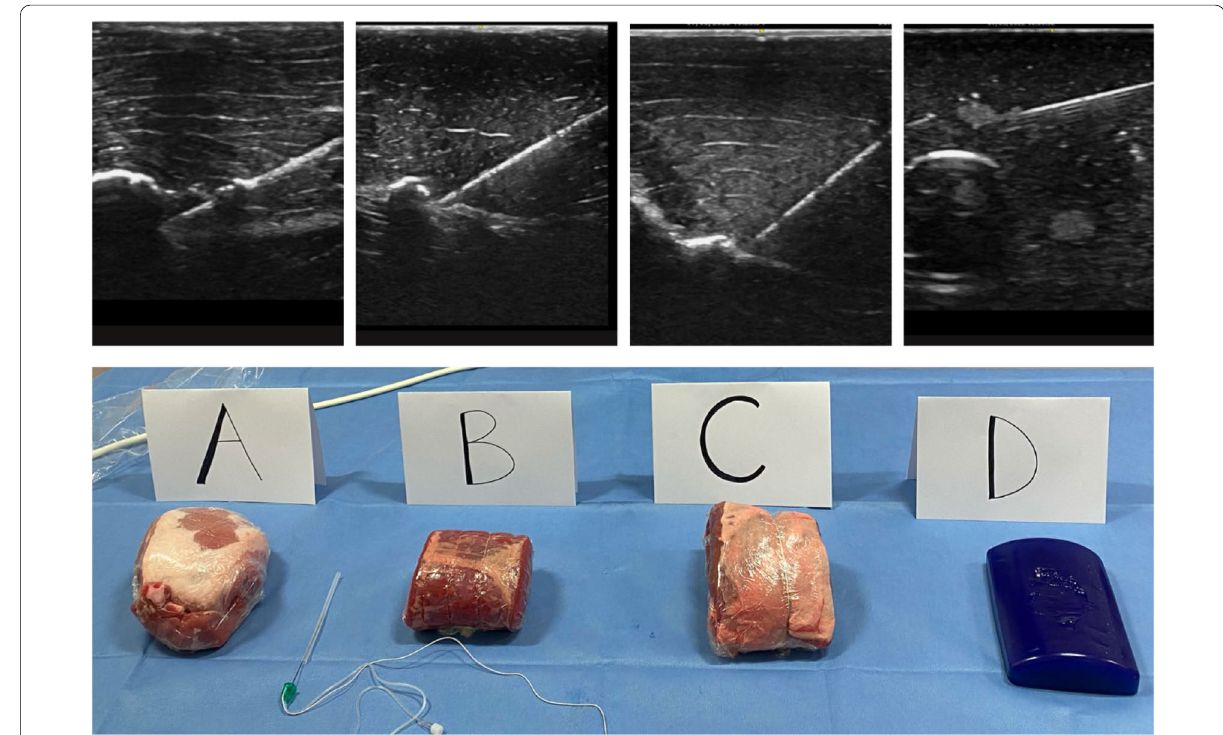
Fig. 2 Specimens A–D with associated ultrasound pictures obtained